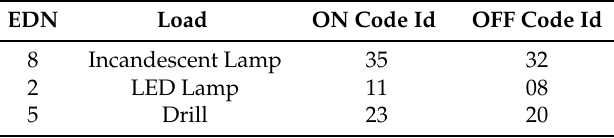
Table 15. Natural subset Devices (Acquisition Example). EDN Load ON Code Id